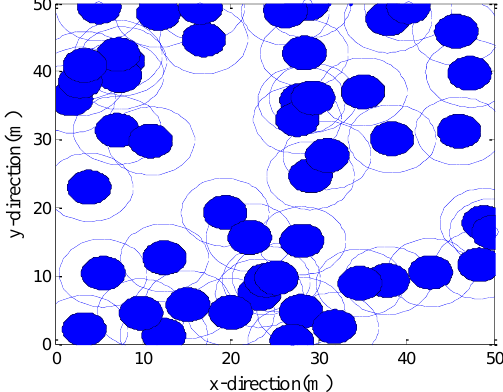
Figure 3. Initial positions of the sensors.